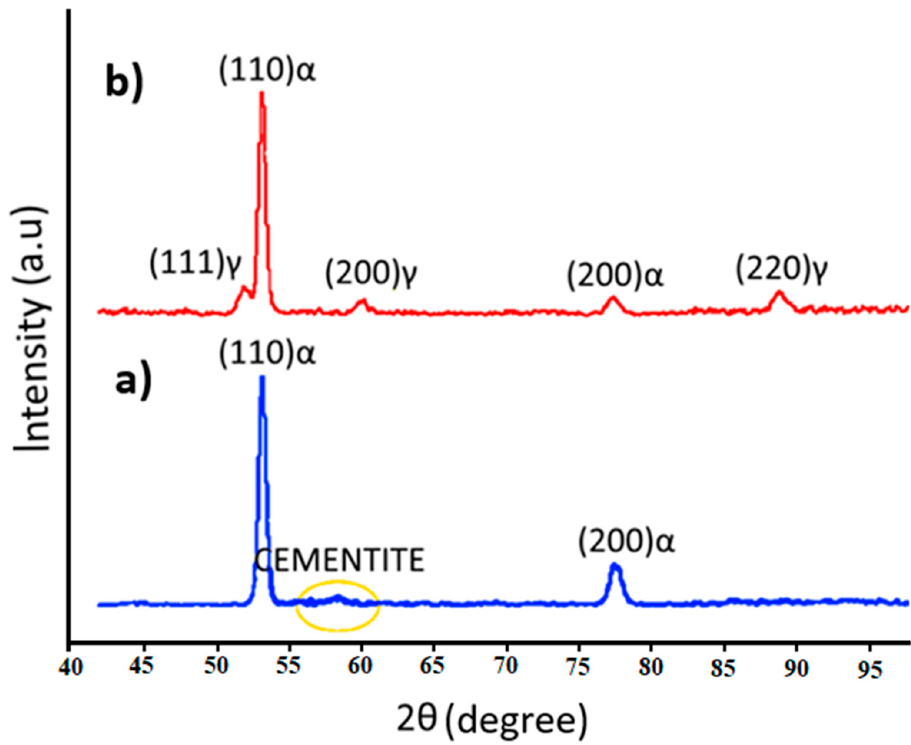
Figure 3. XRD patterns of ( a ) the 1.6511 sample and ( b ) the silicon-modified (1.6511Si2) sample austempered at 300 °C. Note: The cementite peak vanishes when adding silicone.